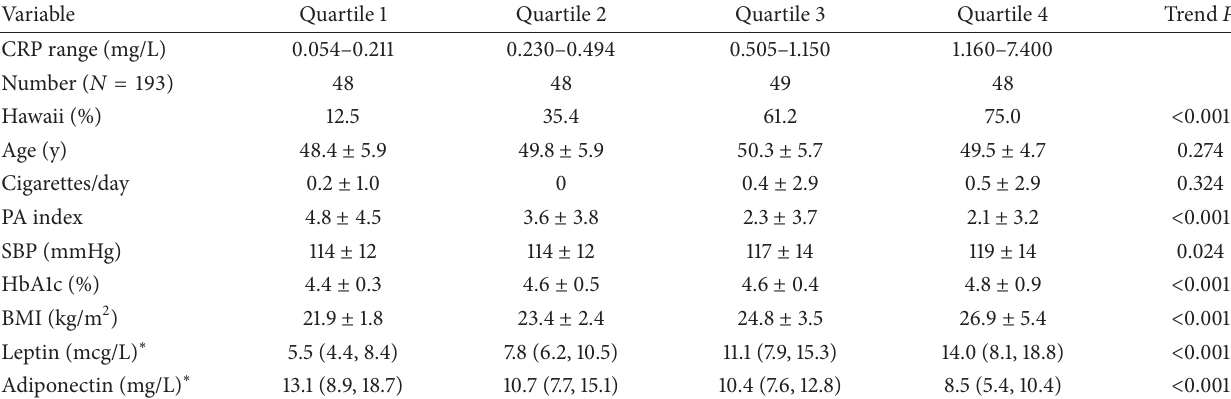
Table 2: BMI, SBP, serum leptin, adiponectin, and other characteristics by quartile of serum CRP in women.